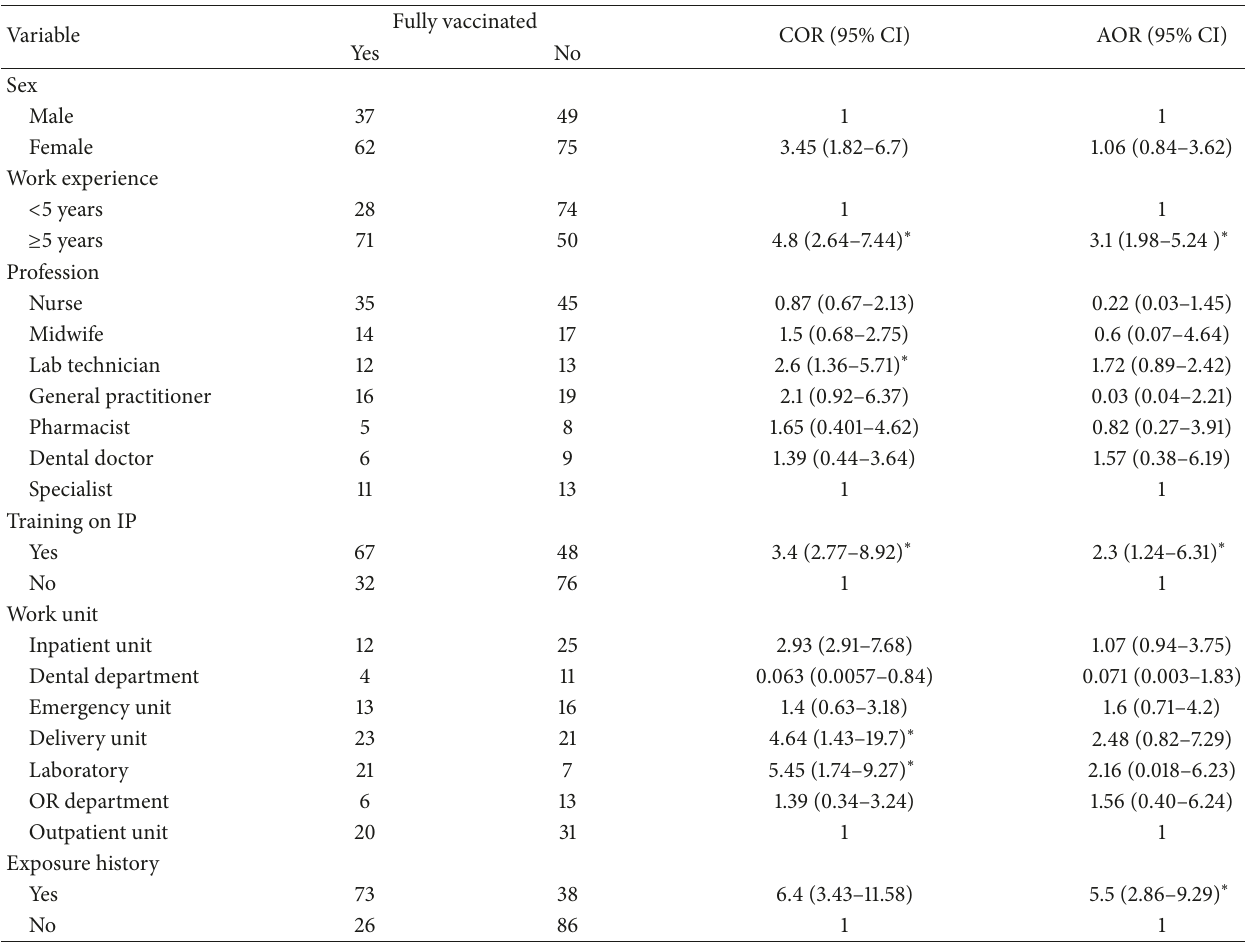
Table 5: Logistic regression of factors affecting full vaccination status among HCWs who received at least one dose, AMHC, Ethiopia,